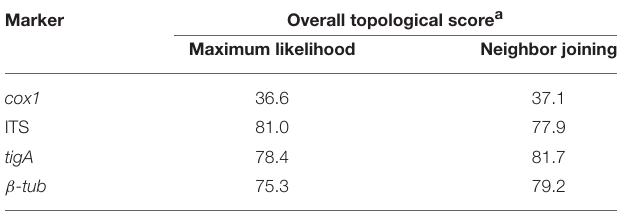
TABLE 5 | Similarity of individual-marker trees to concatenated-sequence tree.